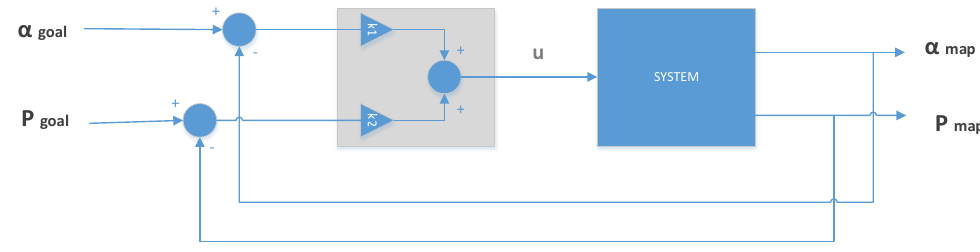
Figure 6. Block diagram that shows the proportional controller described in (1). The set-point is the position and orientation of the point closest to the line shown in Figure 5, left. The error signals are obtained depending on the position and orientation of the vehicle (Figure 5, right). Both, the set-point and the vehicle pose are expressed in map coordinates. The control signal u is the steering value expressed in degrees, that we send to the low-level control module of our